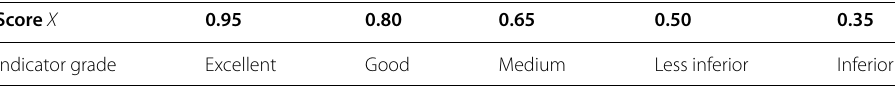
Table 3 Rating table of the key indicators of competitiveness of new competitive advantages of China’s export Score X 0.95 Indicator grade Excellent Good Medium Less inferior